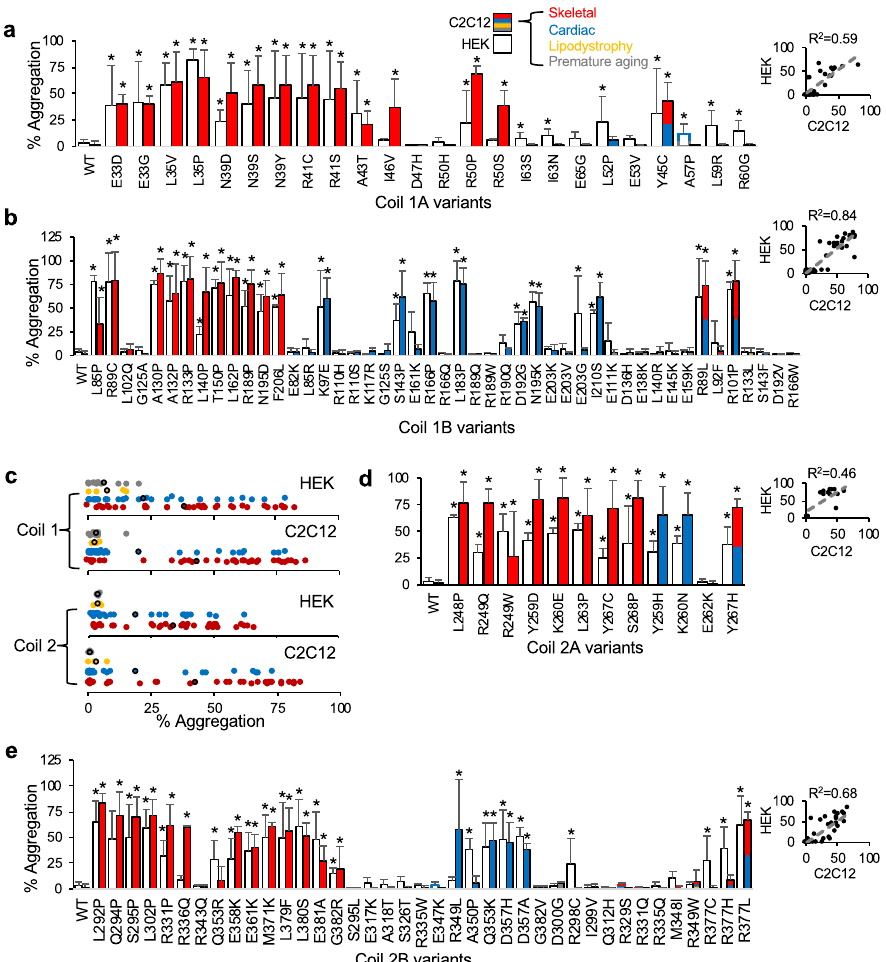
Fig. 2 Lamin A aggregation for CCD variants. a Percentage (%) of cells showing lamin A aggregation plotted for each CCD 1A variant (mean ± SD, n ≥ 3). C2C12 myoblast results are color-coded as follows: skeletal disease-associated variants in red, cardiac in blue, lipodystrophy in yellow, progeria in gray. HEK 293 results are plotted in white or outlined in color if C2C12 myoblast values are zero (e.g., gray and blue for A57P). Inset shows the correlation between HEK 293 cells and C2C12 myoblasts. b CCD 1B variants color-coded as above. c % aggregation distribution for all CCD variants grouped by phenotype for HEK 293 cells and C2C12 myoblasts with average values outlined in black. Variants with crossover disease are plotted more than once for each phenotype. d CCD 2A variants color-coded as above. e CCD 2B variants color- coded as above. Asterisks indicate statistically signi fi cant increases in aggregation over WT ( p <